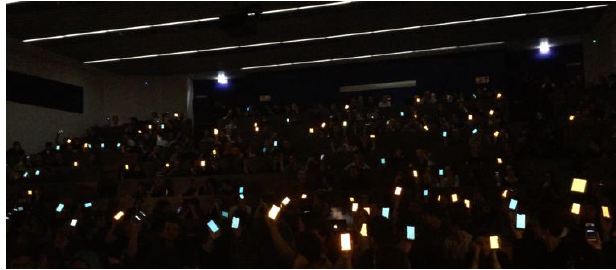
Figure 4. A test of the system with students during a